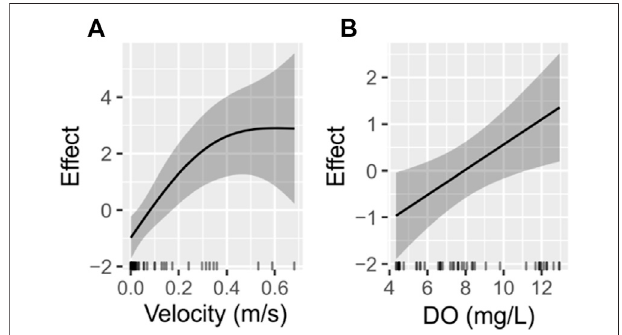
FIGURE 10 | The partial effects of (A) velocity and (B) dissolved oxygen (DO) on total macroinvertebrate abundance estimated by the macroinvertebrate GAM. The solid dark lines show the estimated smooth function of each variable, and the surrounding dark bands are 95% con fi dence